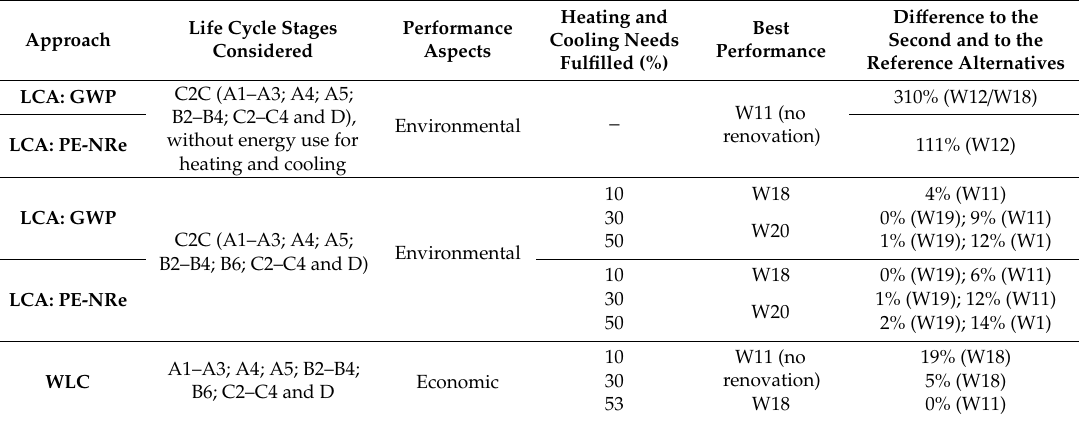
External cavity wall solution that o ff ers the best performance, depending on the dimension